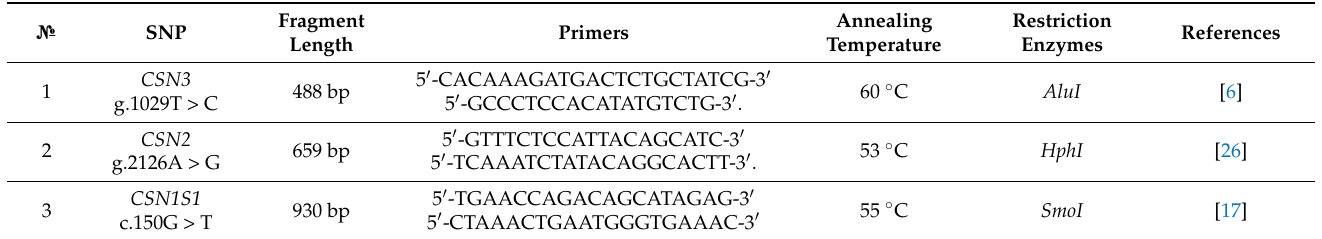
Table 1. PCR-RFLP analysis conditions, restriction enzymes and oligonucleotide primers for casein genes genotyping.